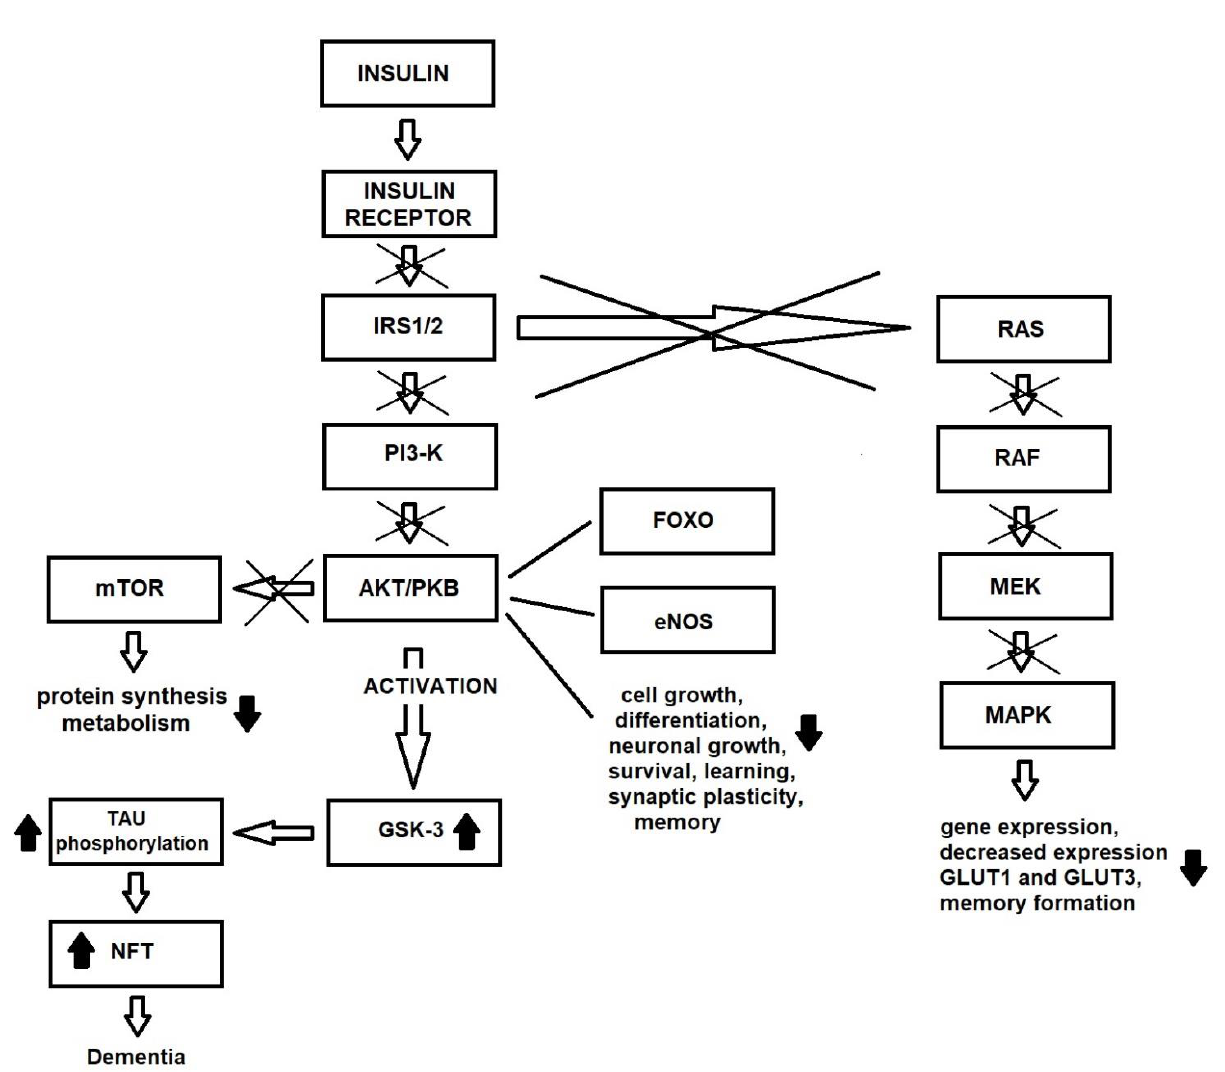
Figure 2. Changes in insulin signaling pathway due to insulin resistance in